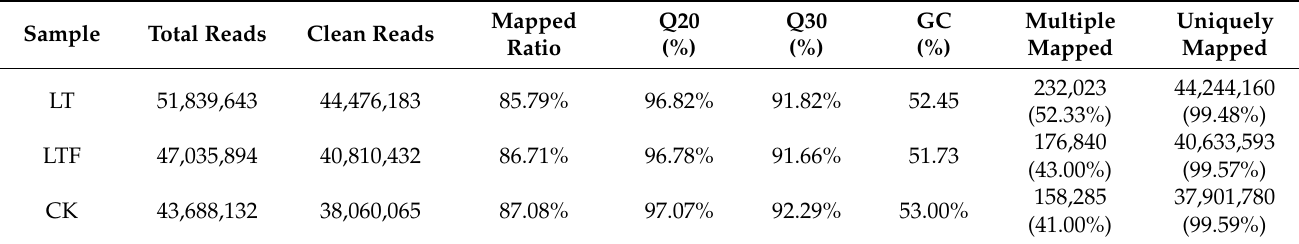
Table 3. Summary of RNA-seq data and reads